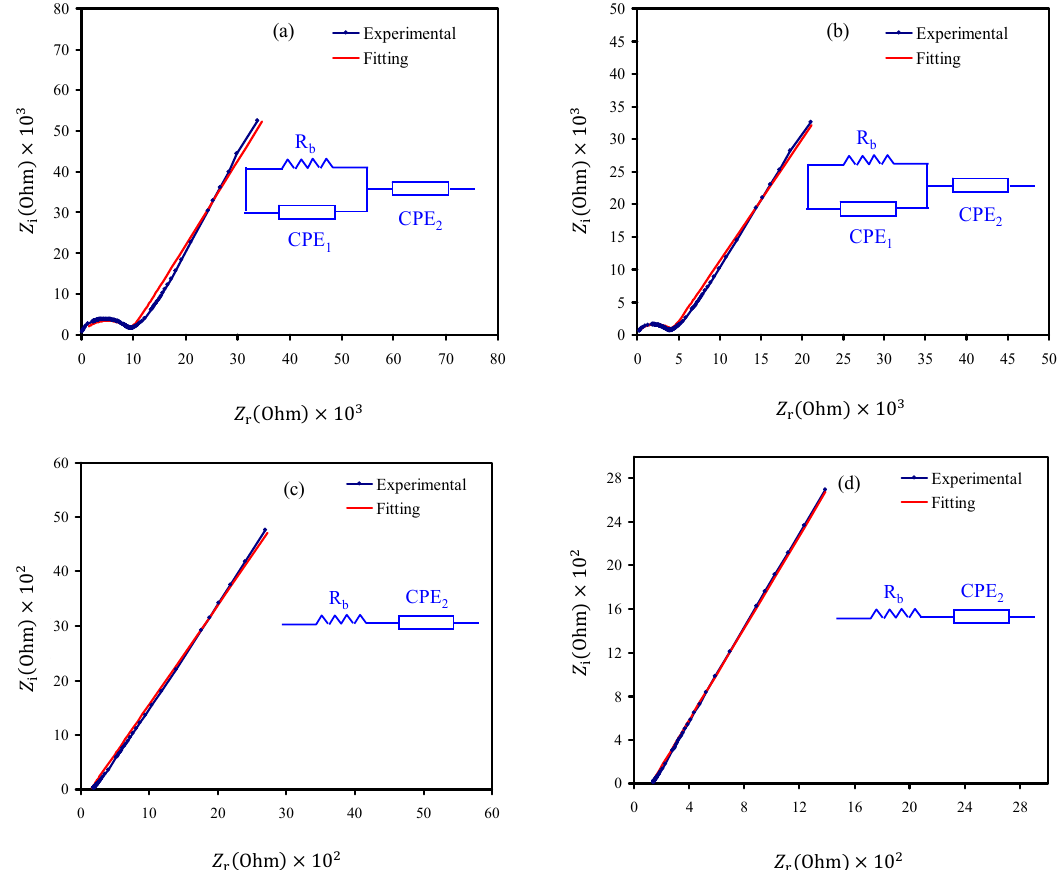
Figure 1. EIS plots for ( a ) CSNZG0, ( b ) CSNZG1, ( c ) CSNZG2, and ( d ) CSNZG3 electrolyte films. Table 2. DC ionic conductivity ( σ dc ) of the un-plasticized and plasticized CS:NH 4 I:Zn(II)-complex system at room temperature.